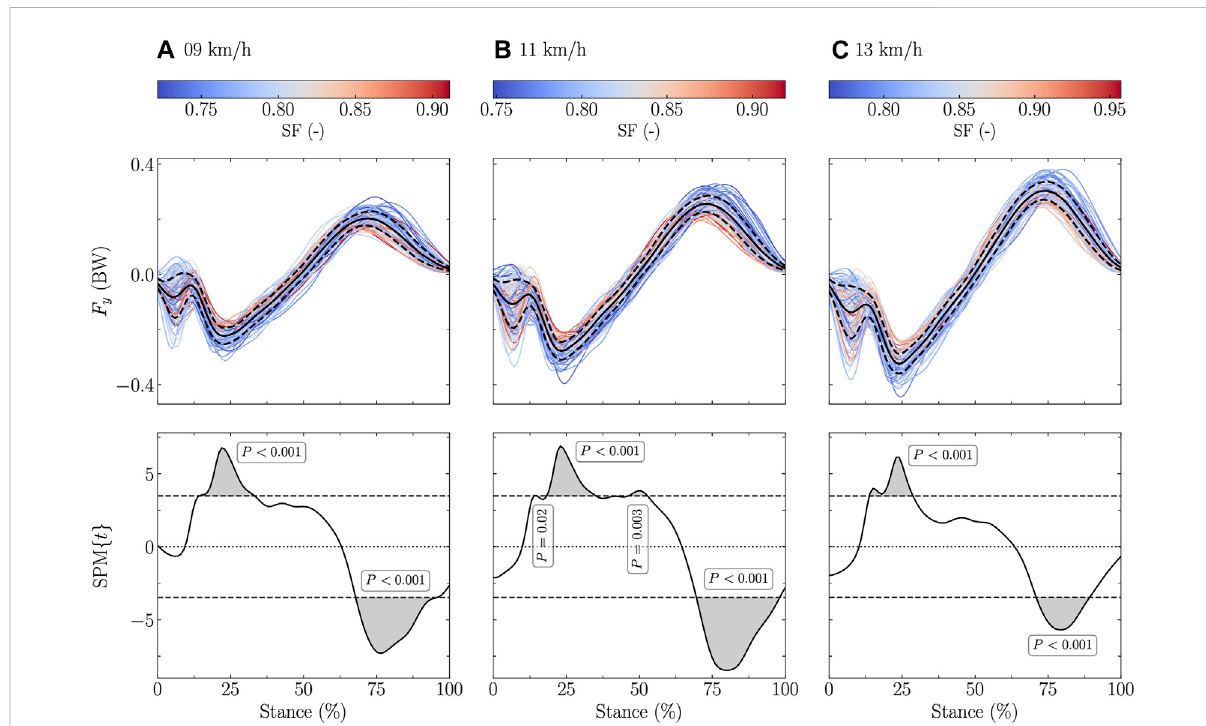
FIGURE 4 Statistical parametric mapping (SPM) analysis, i.e., t-statistics (SPM{t}), of the linear relationship between the fore-aft ground reaction force (F y ) (cid:3) (cid:1)(cid:1)(cid:1)(cid:1) , where g is the gravitational constant and L 0 the leg length, along the running stance phase at (A) and the step frequency (SF) normalized by g / L 0 9 km/h, (B) 11 km/h, and (C) 13 km/h. In the upper panels, F y , expressed in body weight (BW), is depicted for each participant (the color depends on the DF value) and for the mean (black line) ± standard deviation (dashed black line) over all participants. In the lower panels, the black dashed horizontal lines represent the critical (parametric) threshold while the portion of the running stance phase which is statistically signi fi cant ( p ≤ 0.017; Bonferroni correction was applied to take into the three tested speeds) is given by the gray shaded